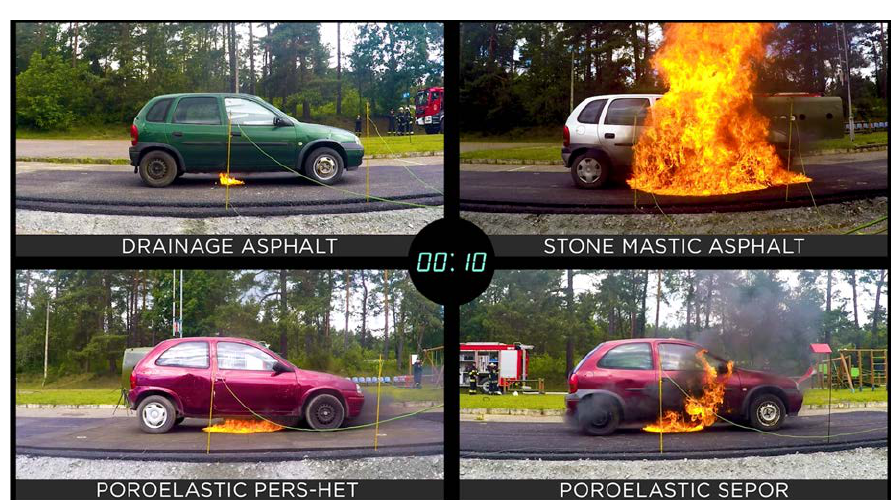
Figure 39. Development of fire 10 s after ignition.